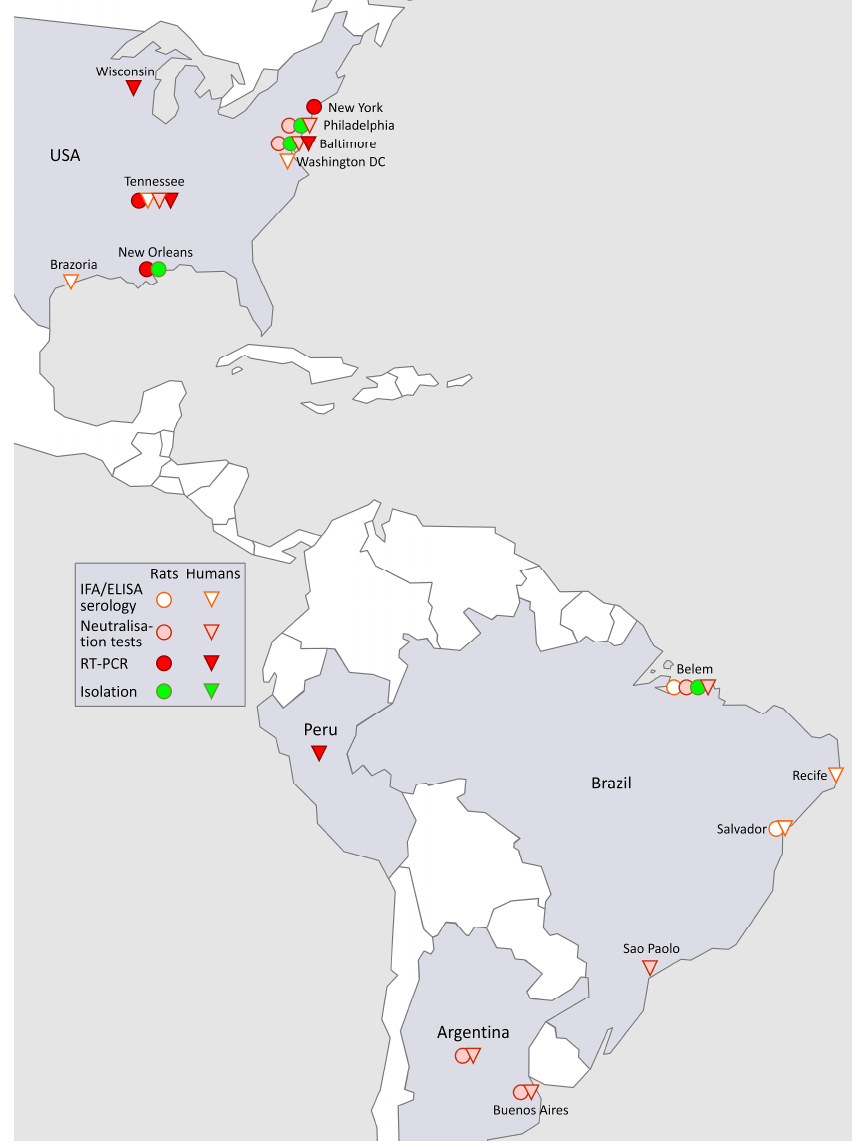
Figure 3. The map does not aspire to completeness and refers only to data given in the text. The first SEOV isolation from a wharf rat captured in Philadelphia, USA, succeeded in 1984 [9], and was rapidly followed by other isolations from wharf rats in di ff erent port cities in North and South America (Belem, Brazil) (see text). The earliest (January 2, 1993) description of eight clinically and serologically documented SEOV-HFRS cases, occurring after local floods in 1990, came from Recife, Brazil [123]. They also constituted the first proof of hantaviral pathogenicity for humans in the New